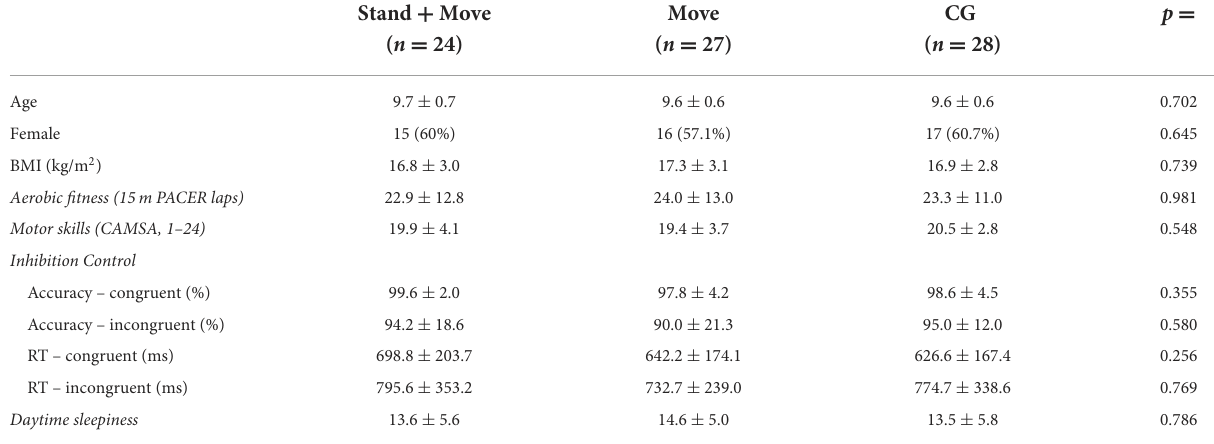
TABLE 1 Baseline characteristics of study